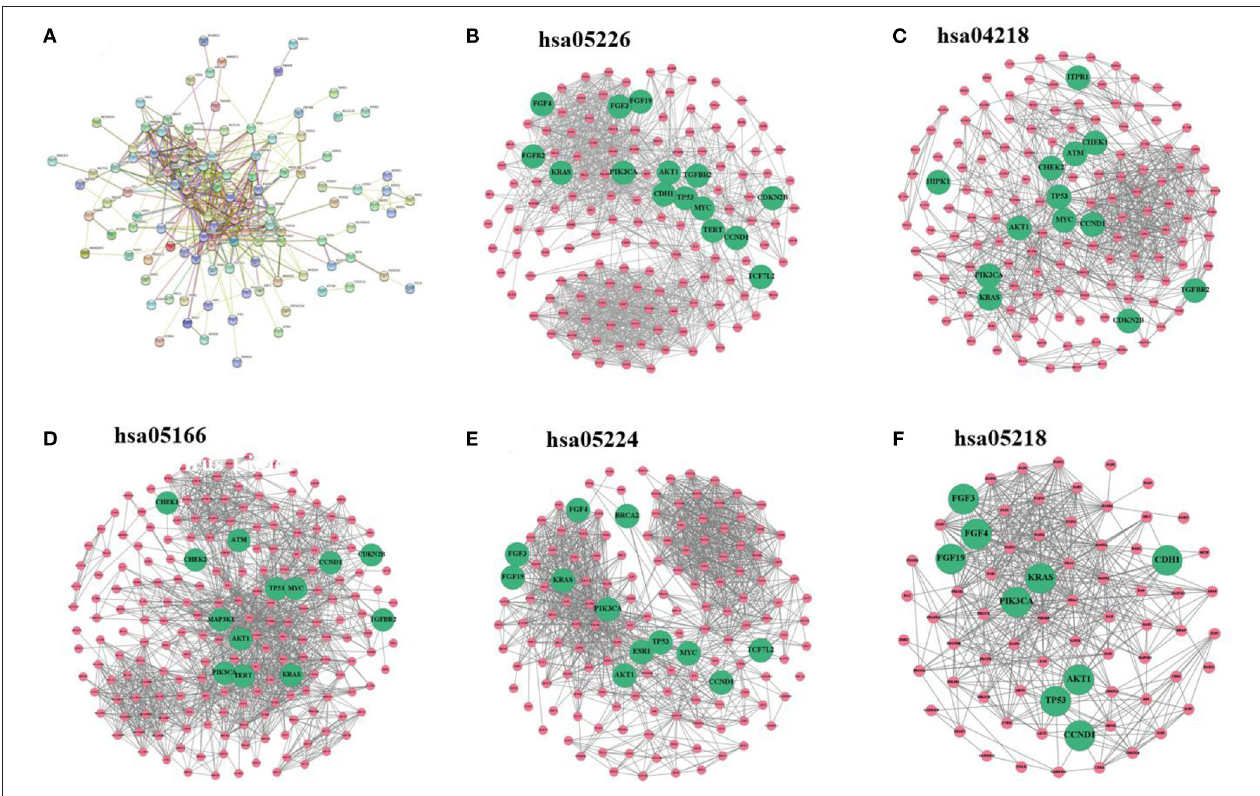
FIGURE 2 | (A) Subnetwork of breast cancer–related genes extracted from the PPI network. (B–F) Subnetworks extracted from the PPI network by using the sets of genes of five KEGG pathways, respectively: gastric cancer, cellular senescence, human T cell leukemia virus 1 infection, breast cancer, and melanoma. Note that green nodes with larger size denote known breast cancer–related genes.